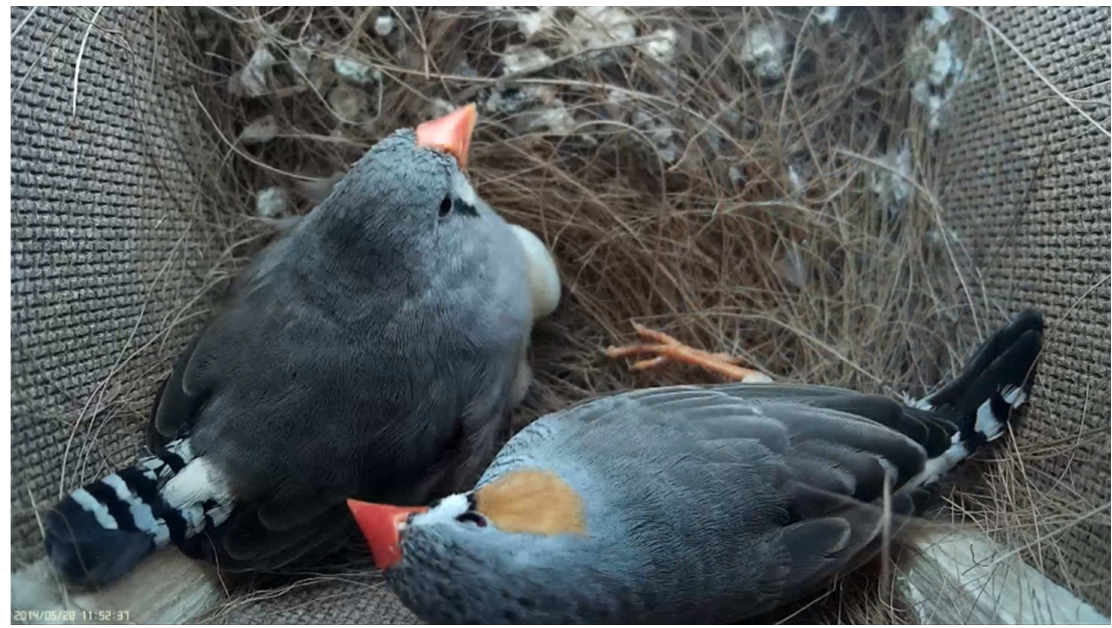
Fig 1. Parental behaviour of breeding zebra finches were recorded using small Mobius digital cameras. The wide field of view coupledwith the ability to record videos in low light conditions and a pronounced sexual dimorphism in this species ensured that parentalsex and activity insidethe nest could be determined